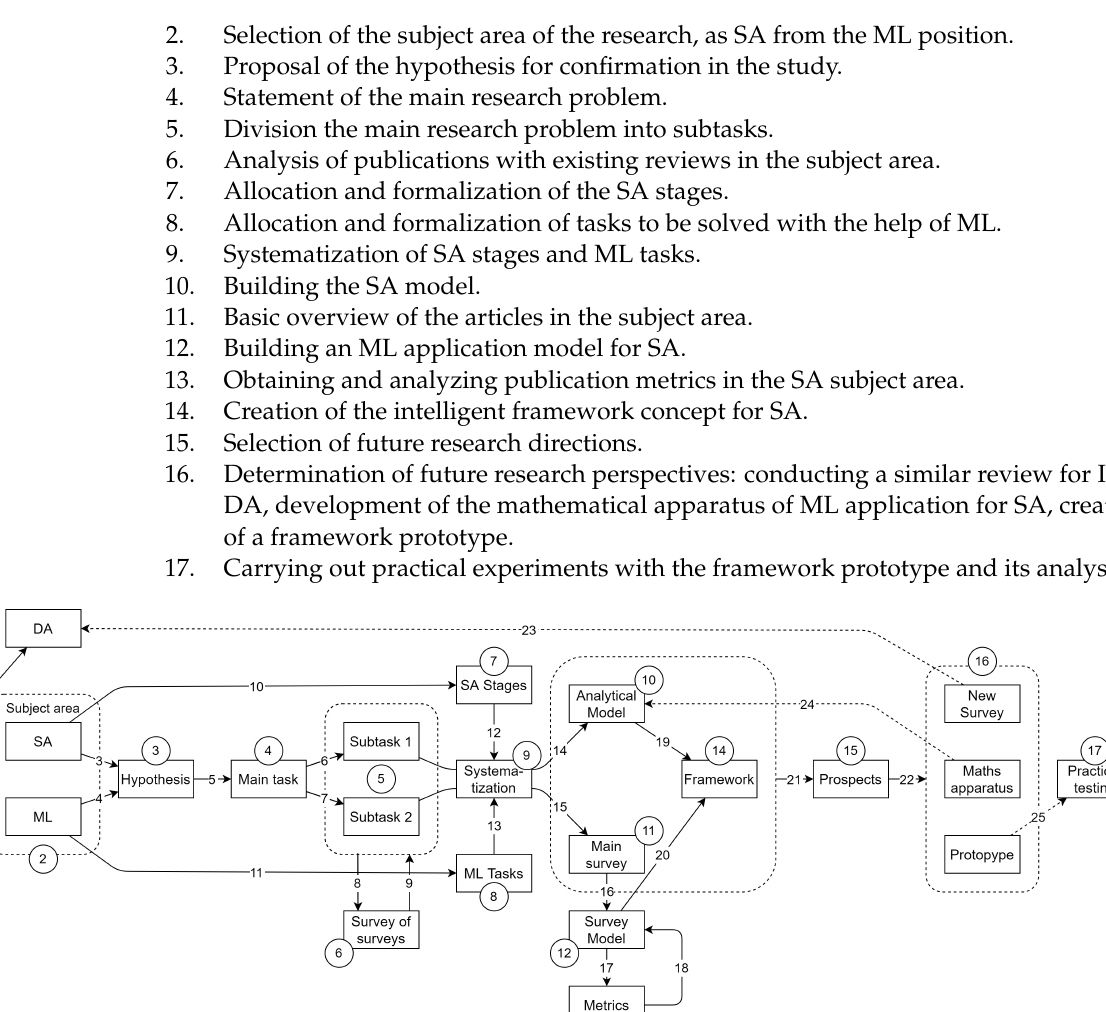
Figure 1. Research